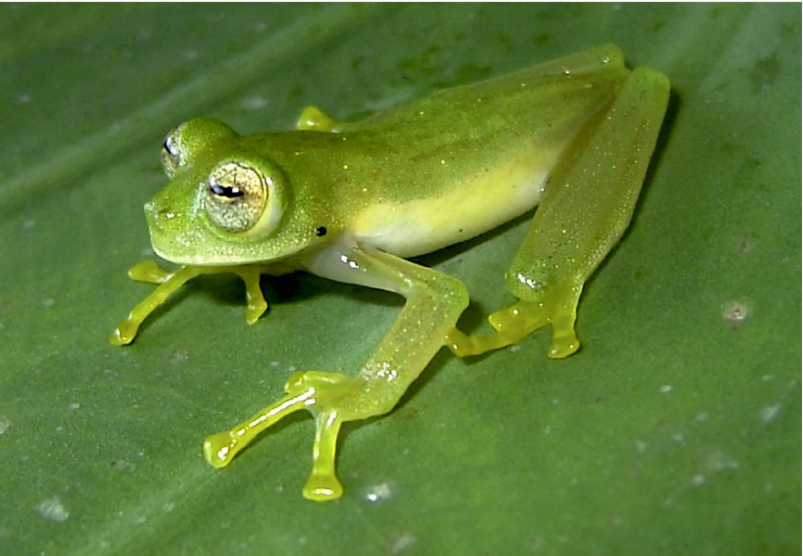
Figure 134. Nymphargus buenaventura in life from Reserva Buenaventura, 1200 m, El Oro province, Ecuador. Photo by Mario Y á